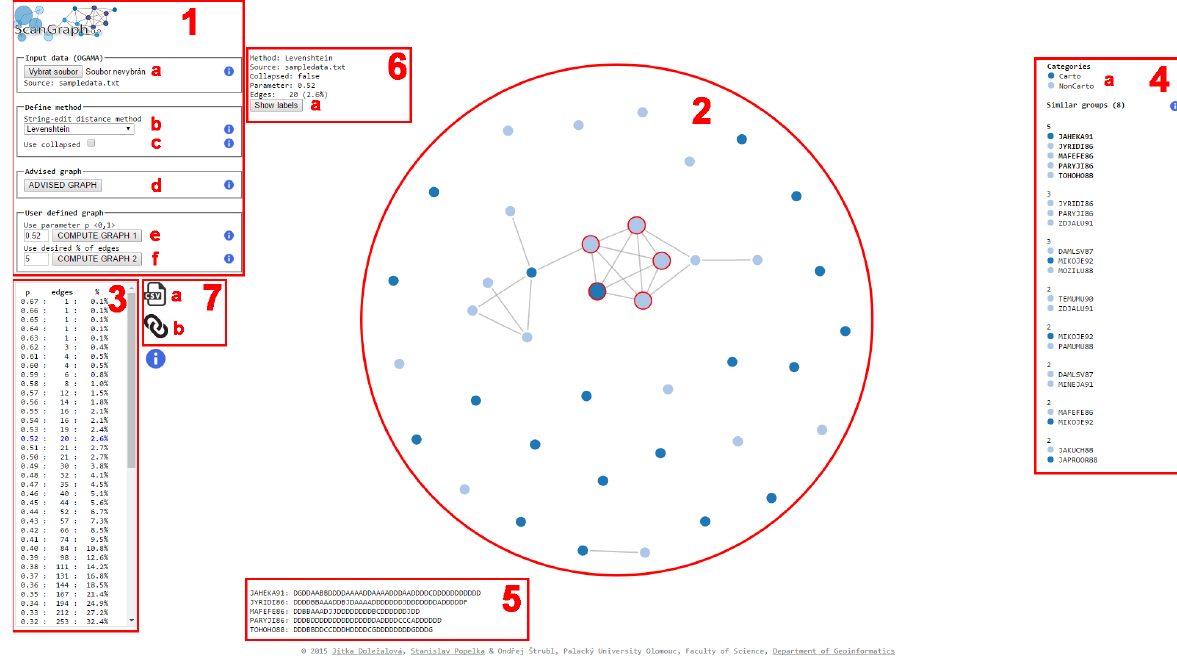
Figure 5. Interface of the ScanGraph